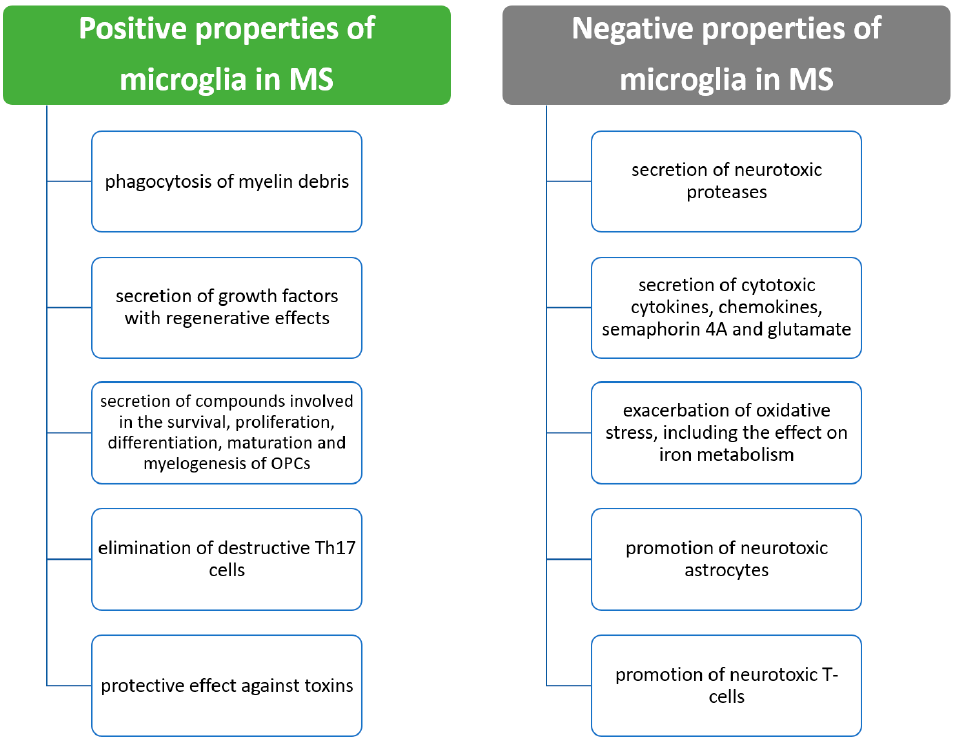
Figure 3. Beneficial and negative effects of microglia in MS.